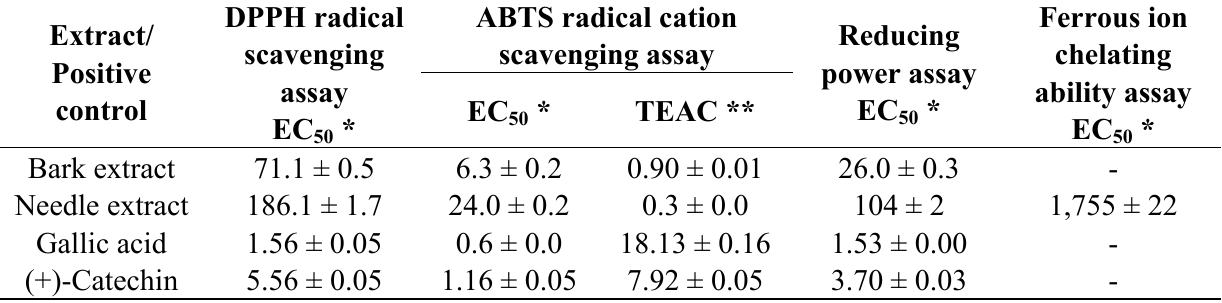
Table 2. Effects of Pinus cembra L. extracts in different antioxidant